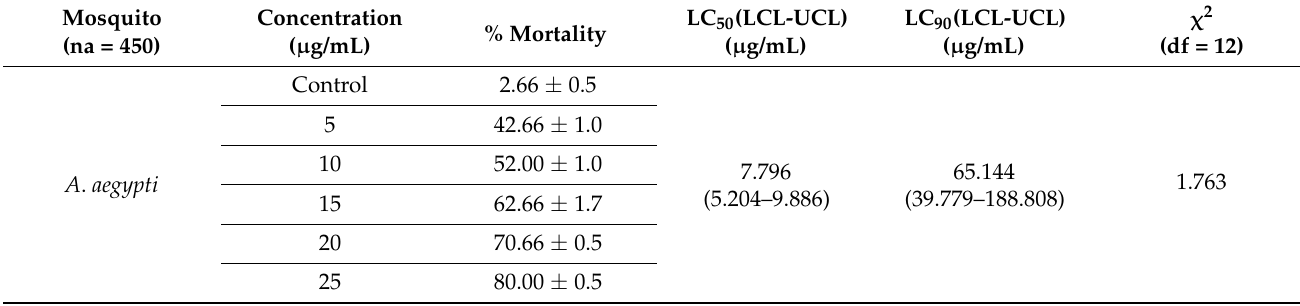
Figure 4. Green nano-pesticide synthesized from M. robertsii against 4th instar larvae of C. quinquefasciatus , A. aegypti and A. stephensi mosquitoes: ( a ) C. quinquefasciatus , ( b ) A. aegypti , ( c ) A. stephensi at 24 h after treatment. Table 1. Mosquitocidal activities of green cluster copper nano-pesticide synthesized from entomopathogenic fungi M. robertsii against 4 th instar larvae of A. aegypti , A. stephensi and C. quinquefasciatus at 24 h after treatment.